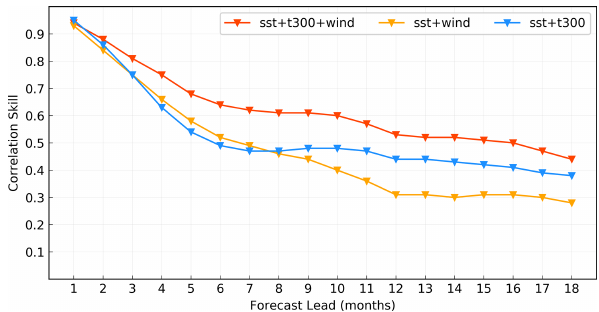
Figure 3. The correlation skill of the Niño 3.4 index of the ENSO- MC model with different